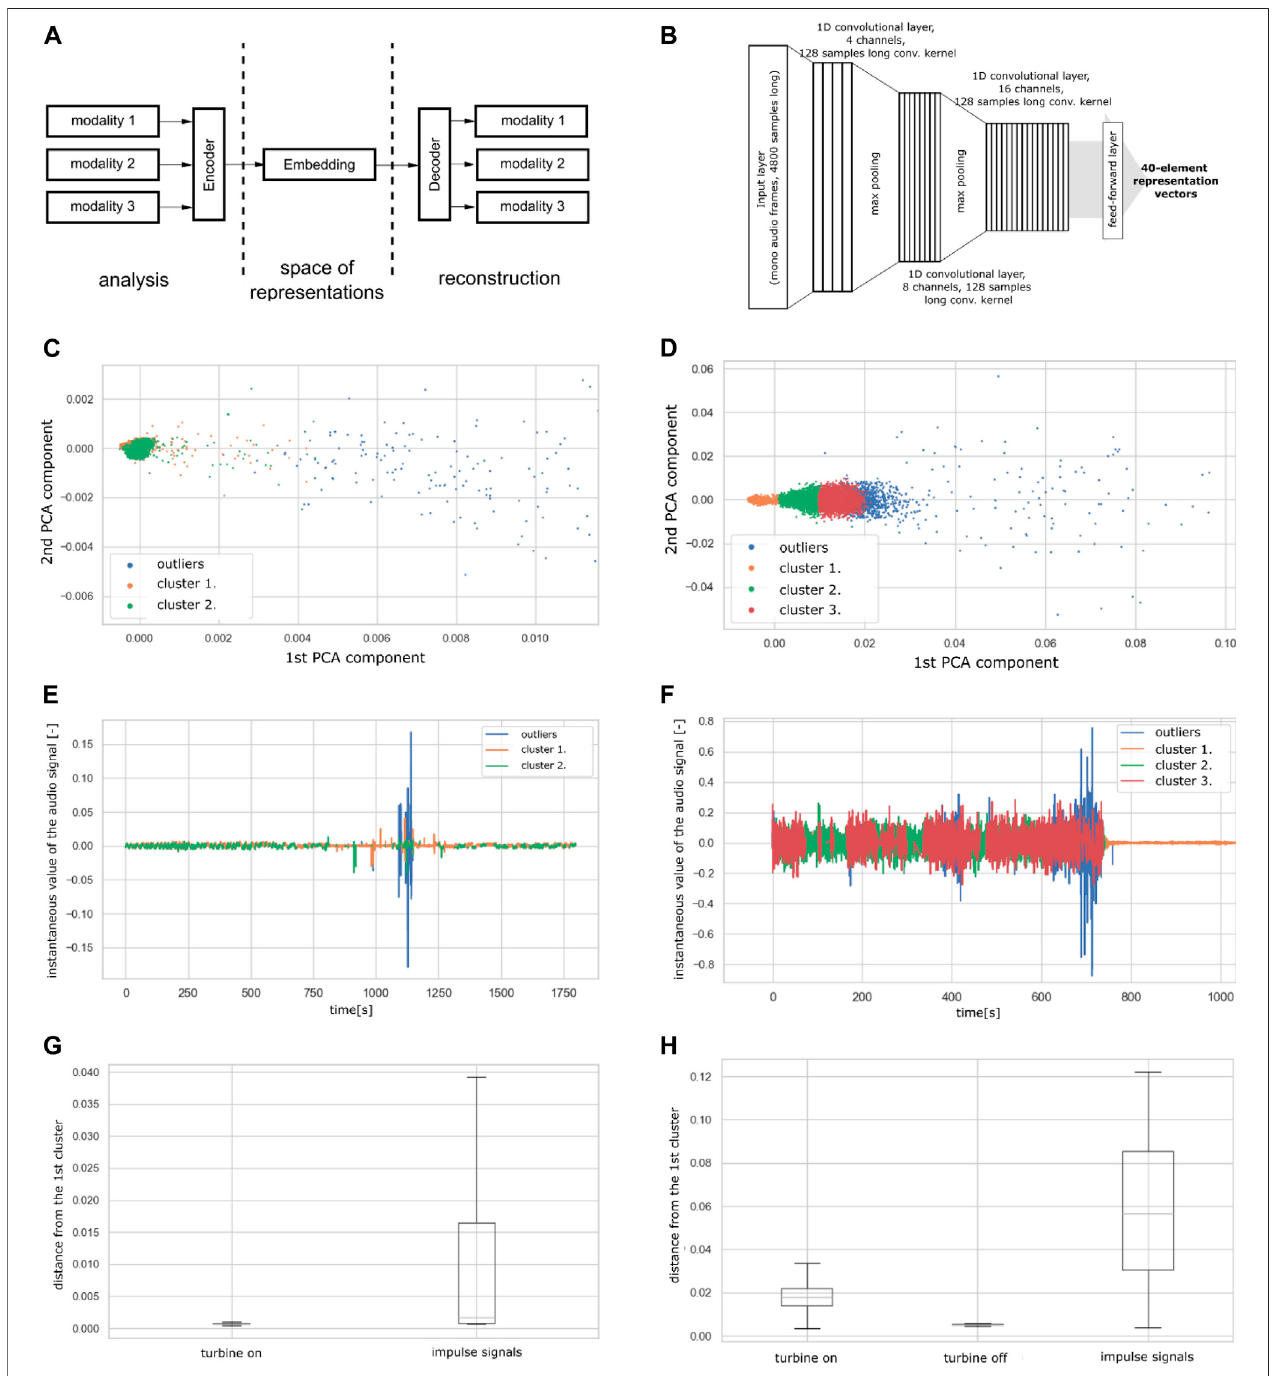
FIGURE13| Neuralnetworkapplication: (A) thearchitectureofanautoencoderneuralnetwork, (B) autoencoderarchitectureusedtoanalyzeacousticsignalsfrom wind turbines, (C) result of parameterization and signal clustering-visualization was obtained by parameter reduction with PCA method, (D) result of parameterization and clustering obtained by reducing the parameters with the PCA method, (E) and (F) results in the time domain, (G) and (H) -box plots illustrating the distance ofpoints extracted from individual signal fragments from cluster 1.